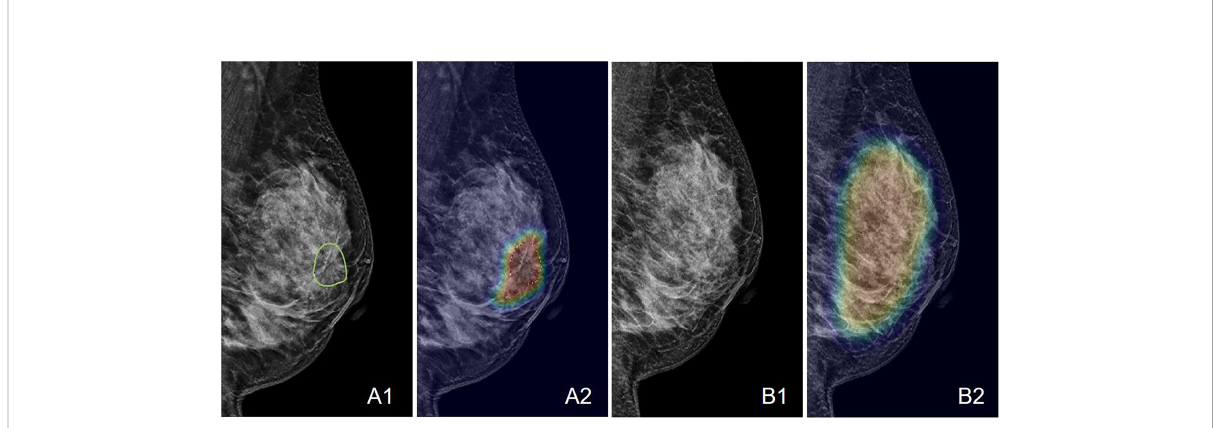
FIGURE 7 An example of the Grad-CAM map of the architectural distortion in the LMLO view of (A) DBT and (B) FFDM images of a 53-year-old patient diagnosed with invasive ductal cancer. The BI-RADS score is 4B. The radiomics score is 0.65, and the deep learning probability is 0.62, both correctly diagnosing this case as malignant. When the developed deep learning model from DBT is applied to FFDM, the probability is 0.32, false-negative. The detected suspicious area covers the entire dense tissues, showing the architectural distortion on FFDM cannot be detected.